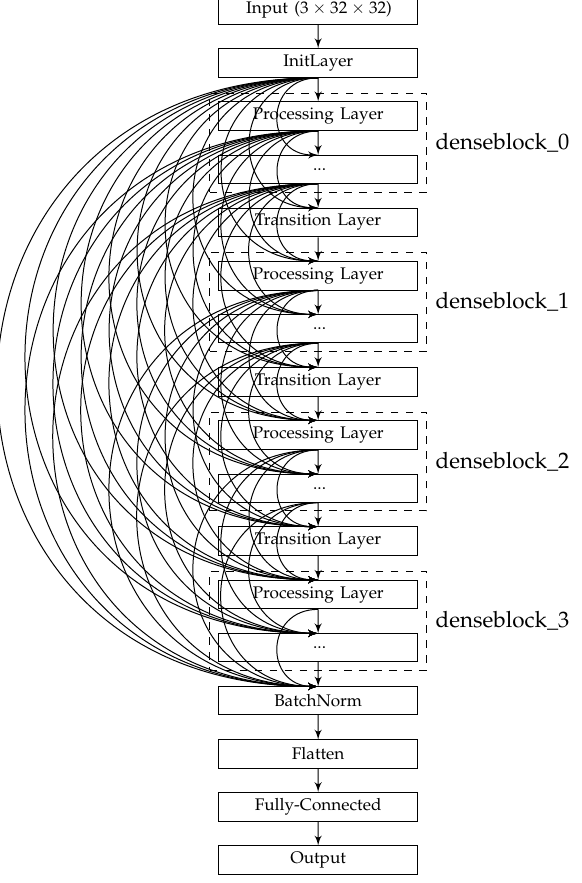
Figure 4. The proposed skeleton